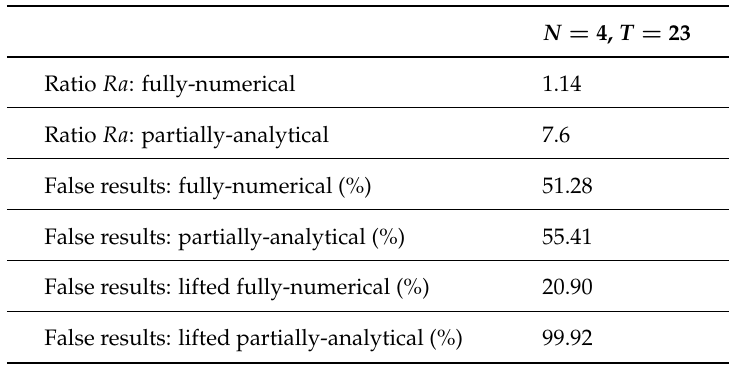
Table 7. UWB self-calibration optimization results based on real 2D measurements. The identified false optimizations have an error larger than 0.1m.